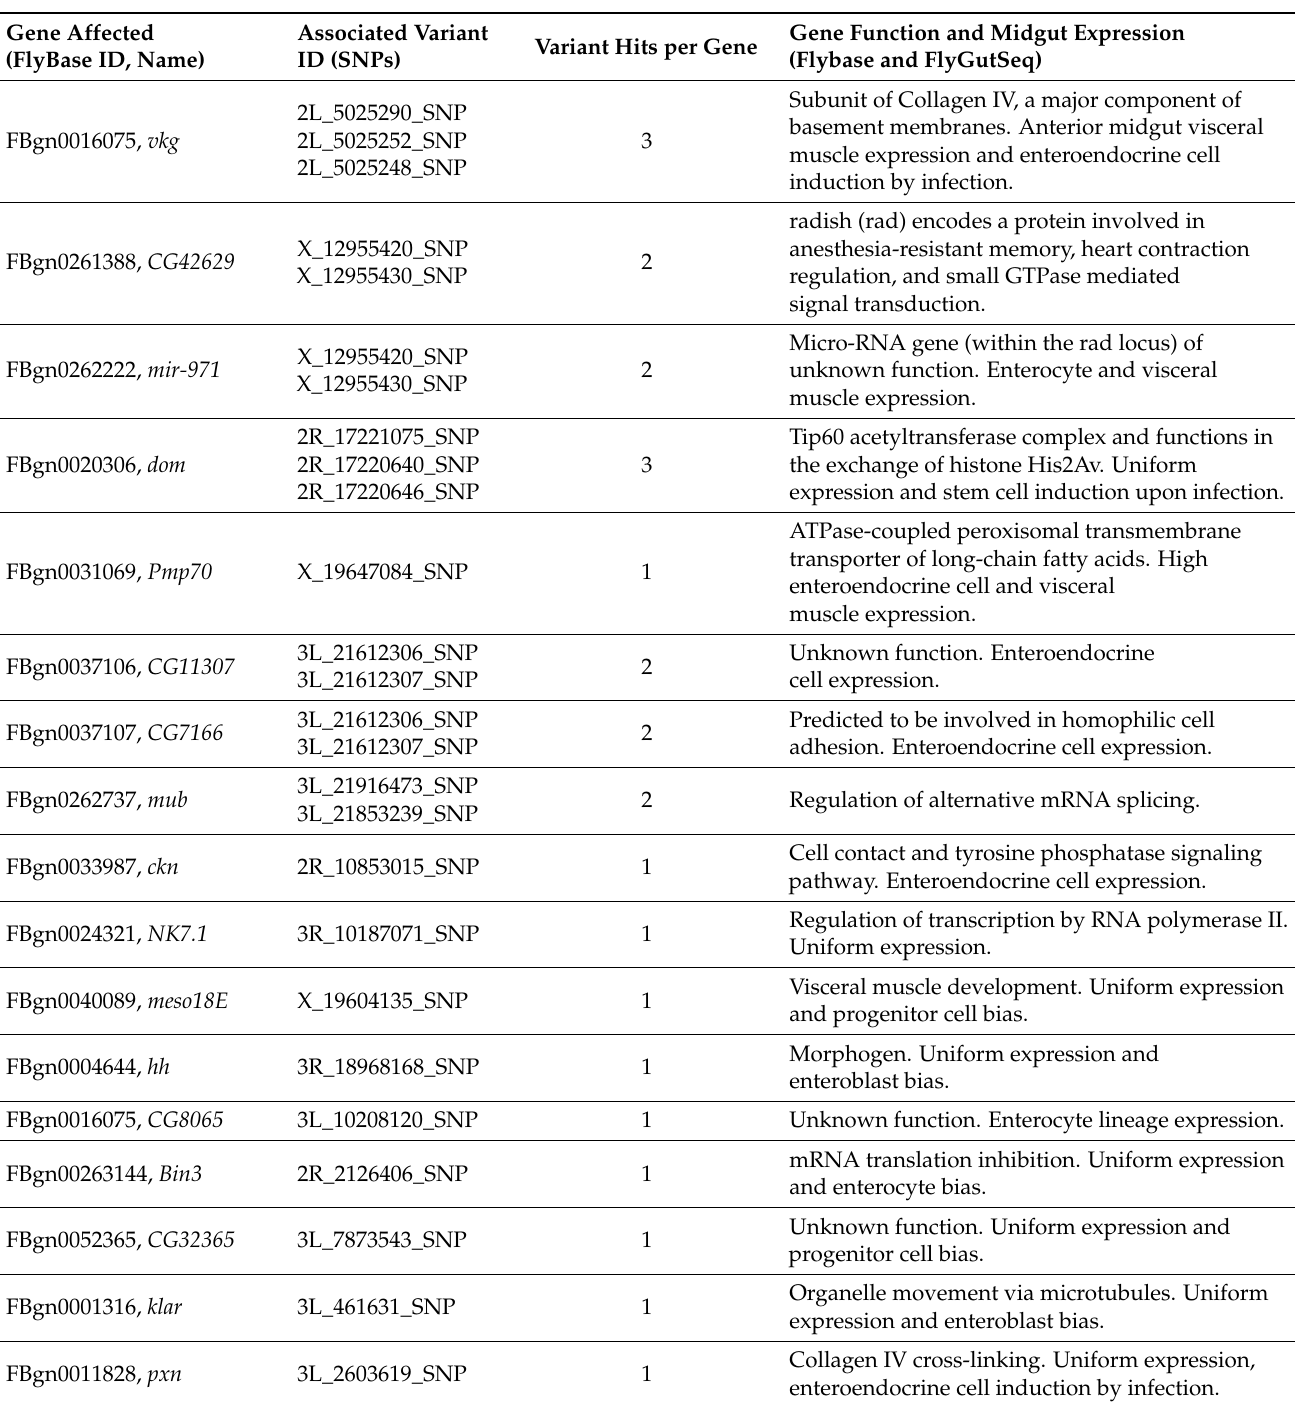
Table 1. Defecation rate associated genes identified by GWAS analysis. Genes associated with defecation rate identified by phenotypic analysis of 150 DGRP strains and the DGRP GWAS Webtool (http://dgrp2.gnets.ncsu.edu/) (accessed throughout 2017–2022). Commonly occurring polymor- phisms (SNPs) associated with 17 genes and their function and midgut expression are